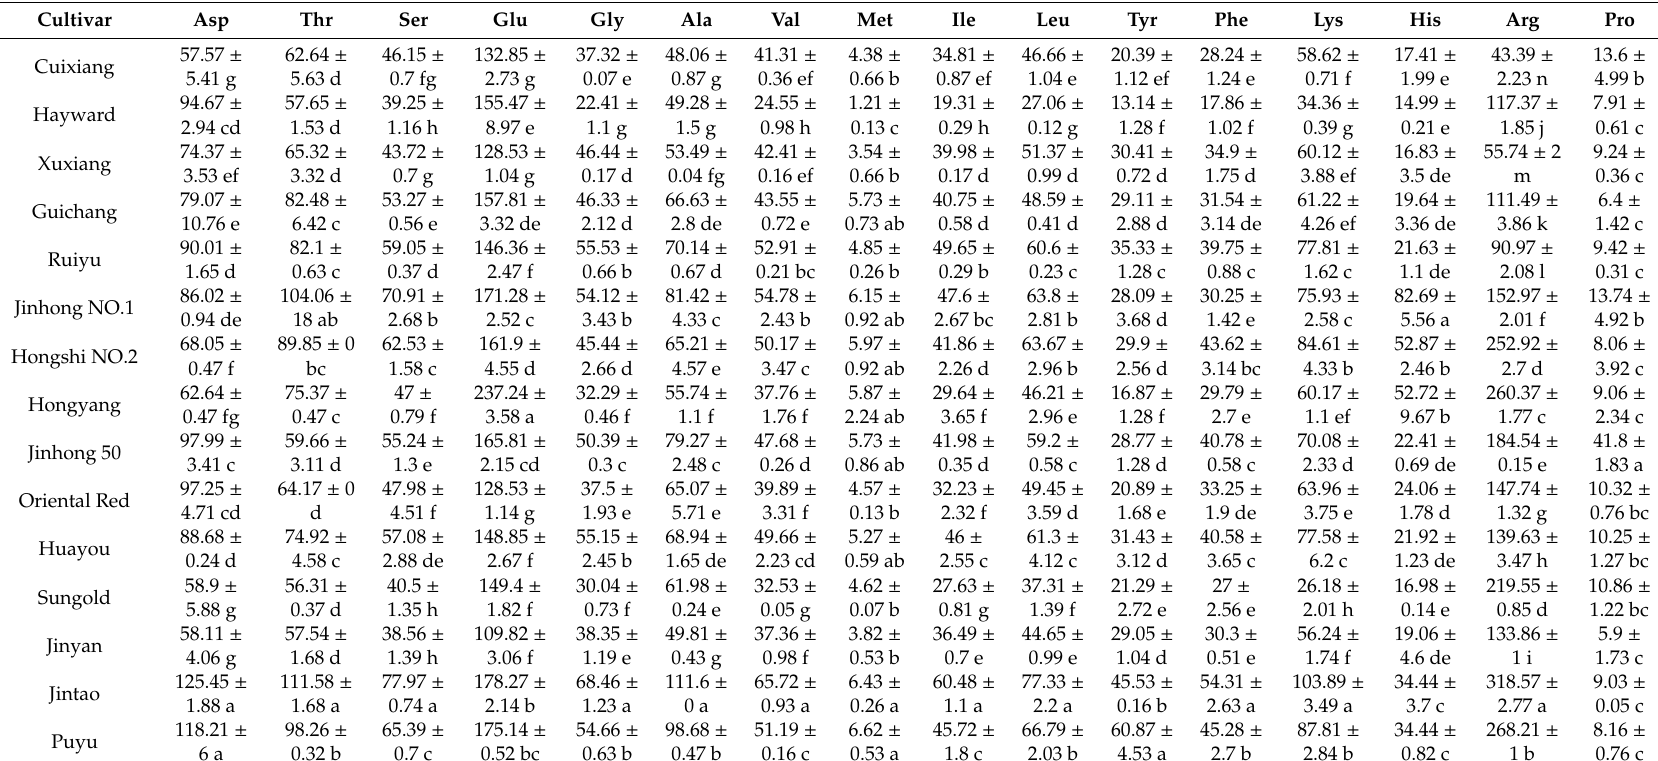
Table 4. Sixteen kinds of amino acids (mg / 100 g) in 15 kiwifruit